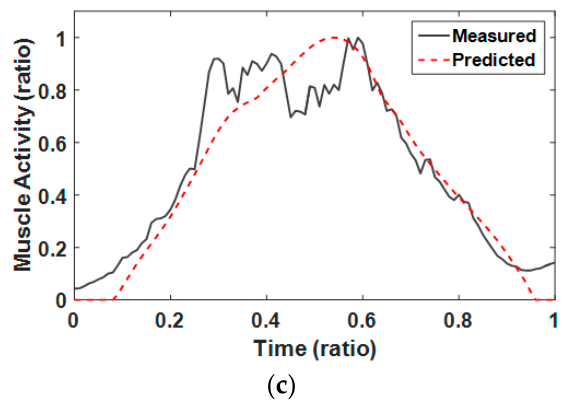
Figure 7. Comparison of measured EMG data of right leg with simulated muscle activities in the case where the subject was 1800 mm in height and the foot position and guide angle were 250 mm (=0.14 h) and 0° respectively: ( a ) vastus lateralis; ( b ) vastus medialis; and ( c ) rectus femoris. Table 2. NRMSEs of measured and simulated muscle activities of right leg.